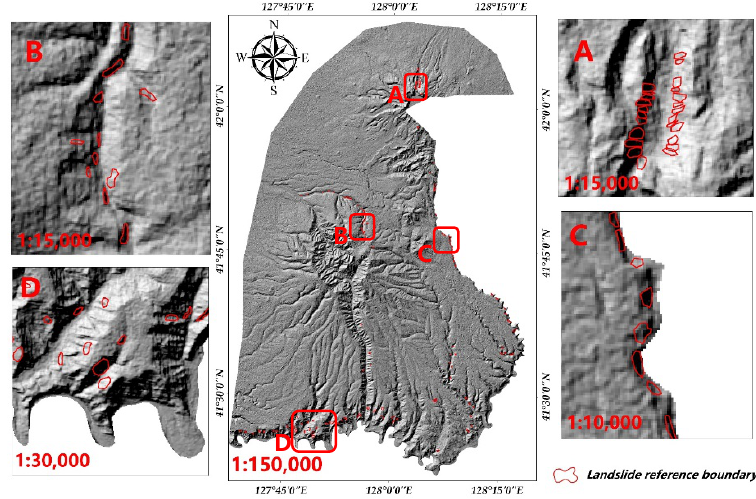
Figure 2. Reference boundary data.